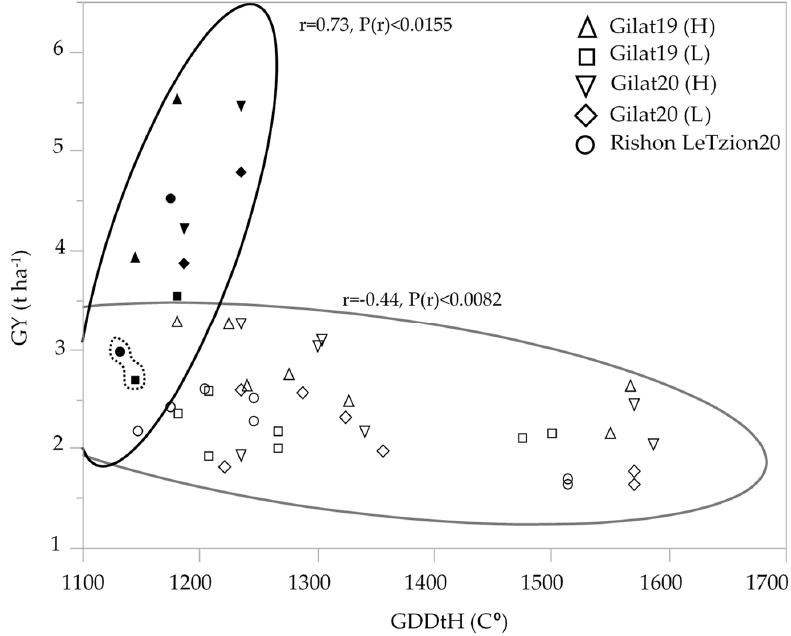
Figure 2. Association between durum wheat grain yield (t ha − 1 ) and growing degree days to heading across five environments: modern durum cultivars (solid symbols); durum landraces (hollow symbols). The GY mean of modern cv. Solet under the two most extreme environment is marked by a dashed line.